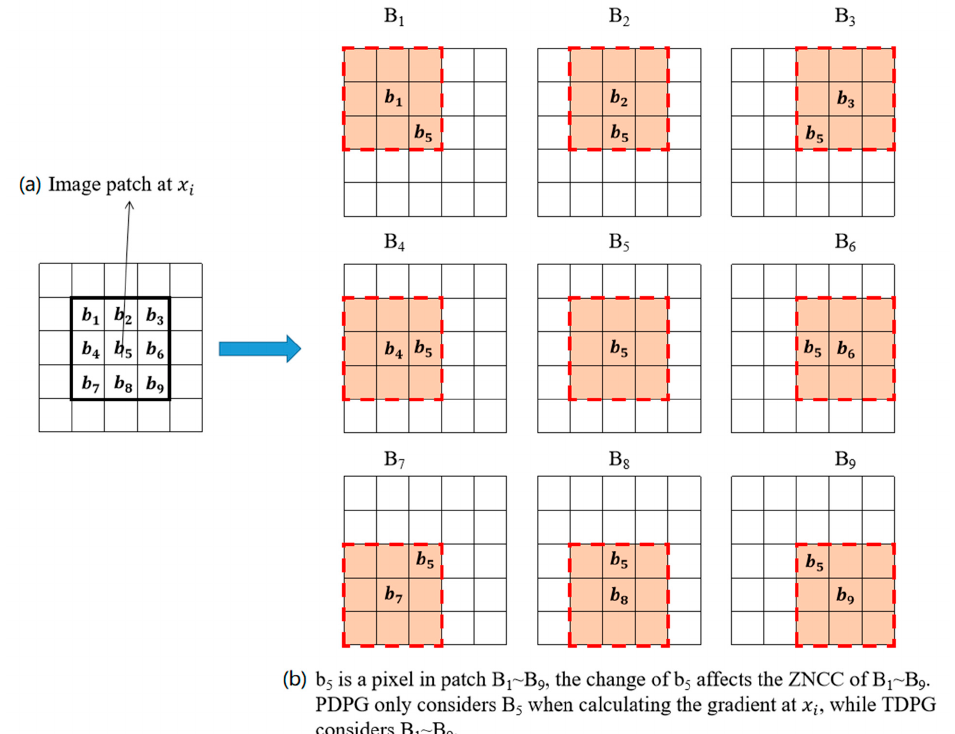
Figure 3. The difference between PDPG and TDPG.